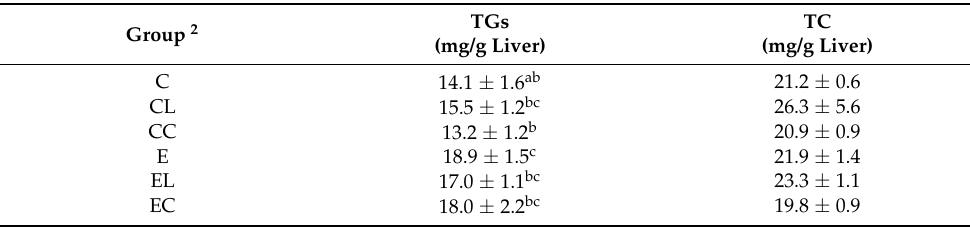
Table 7. Effects of different dietary fat sources on hepatic triglycerides (TGs) and total cholesterol (TC) concentrations in rats 1